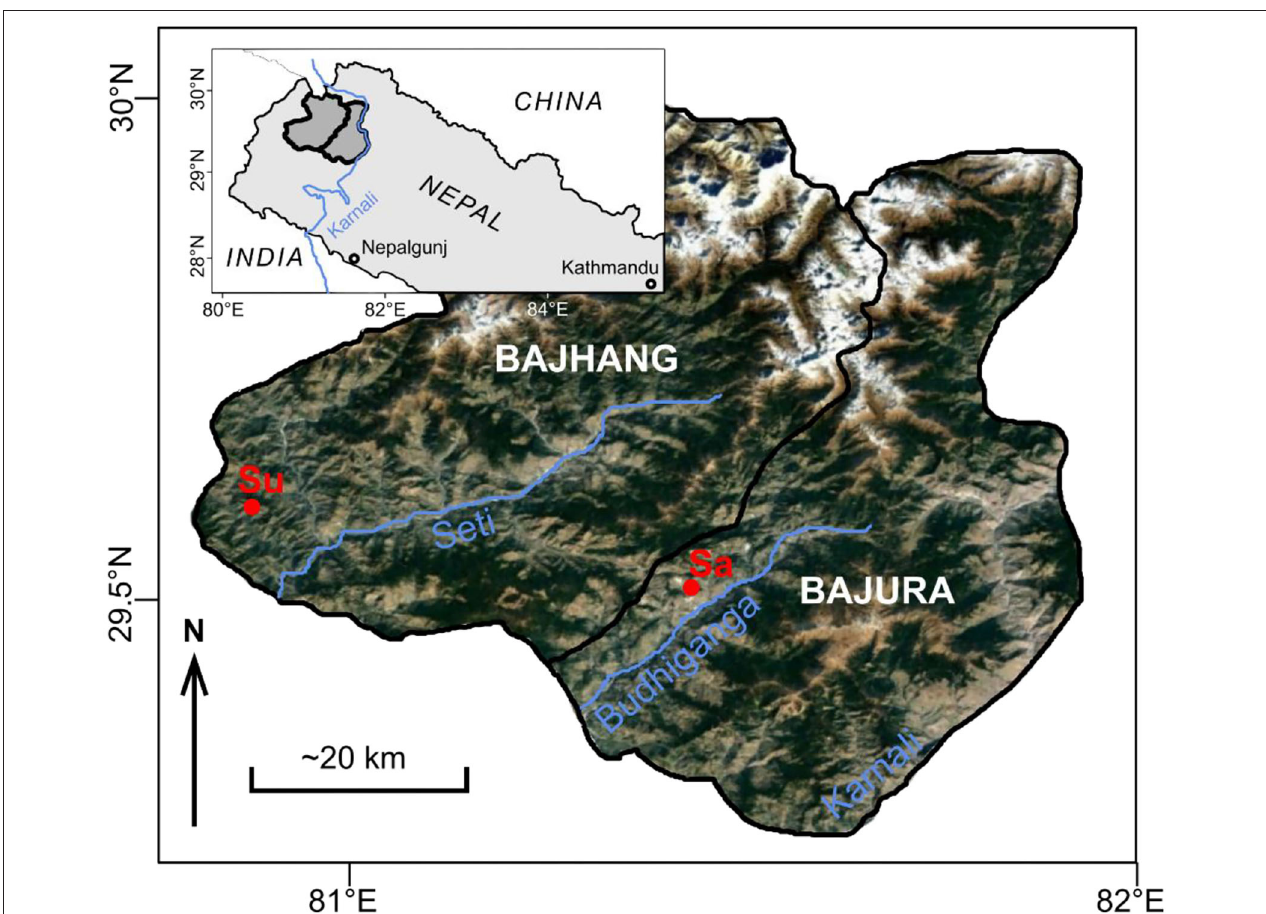
FIGURE 2 | Location map showing satellite imagery of Bajhang and Bajura districts within western Nepal. Sa, Saraswati Secondary School; Su, Sunkuda Higher Secondary School.